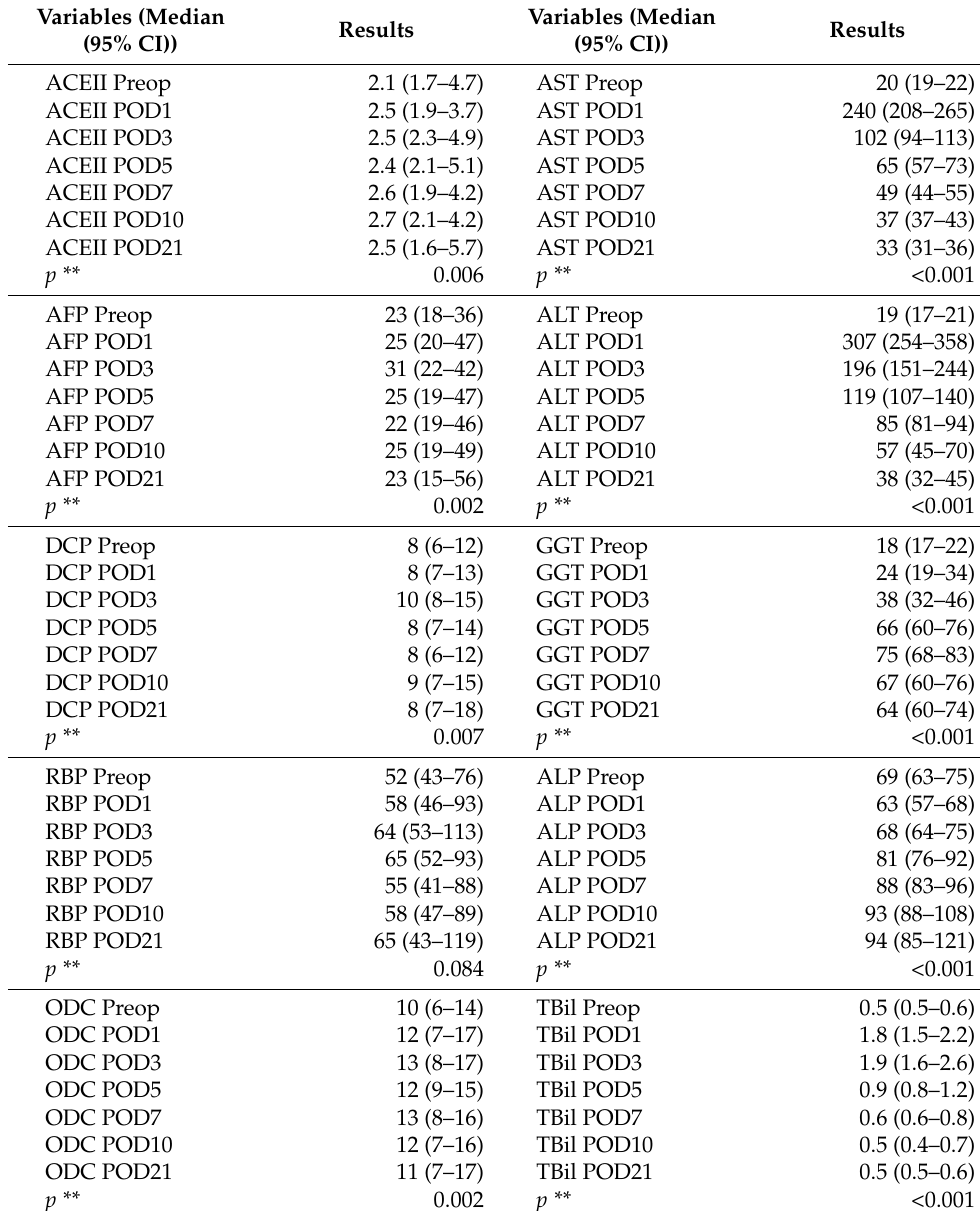
Table 2. Routine and regeneration-related biochemical parameters of the LLDs included in the study